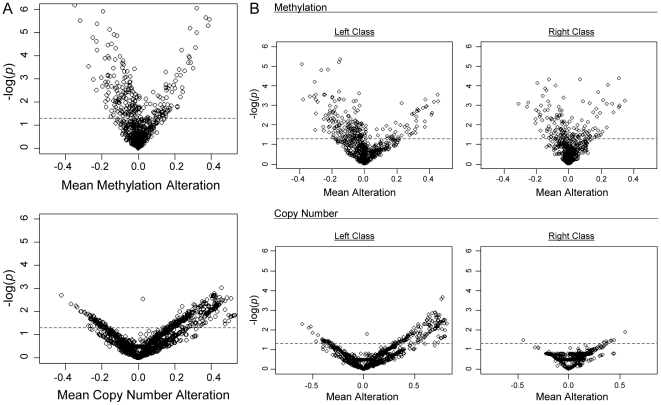
Log significance plots for mean alteration difference in array genes.Gene regions were compared to their expected value (normal tissue betas for methylation and copy number = 2 for CNA) and t-tests were performed. Negative log-transformed p-values (generated by tumor/normal t-tests) are shown on the y-axes and the indicated mean alterations are displayed in the x-dimension. The space above the dotted line represents a significance level of p<0.05. A) Promoter-associated methylation alterations (663 genes) and copy number-altered genes (n = 15,790) are shown and B) separated by overall methylation class structure (Left Class n = 10, Right Class n = 9) as defined by grouping the methylation classes based on the original RPMM dendrogram splitting in [20].